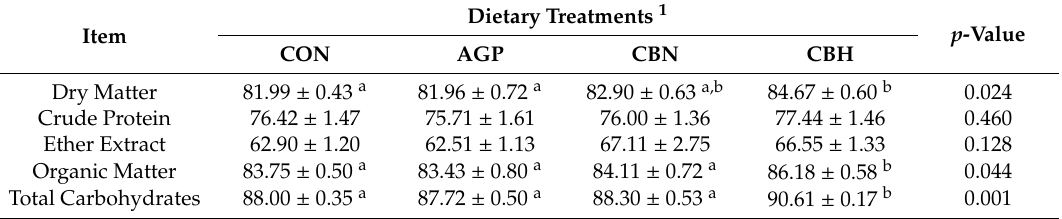
Table 3. E ff ect of dietary C. butyricum on feed nutrient ATTD (mean ± SE 2 ,